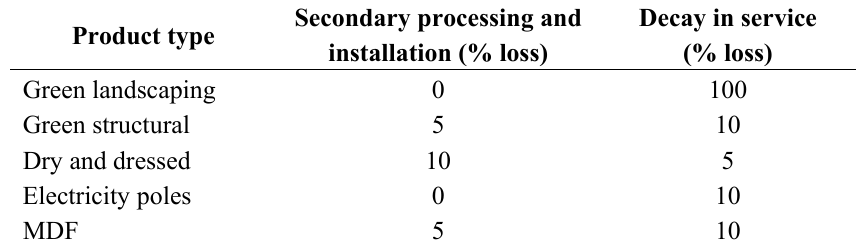
Table 4. Biomass losses due to secondary processing and installation of products and decay in